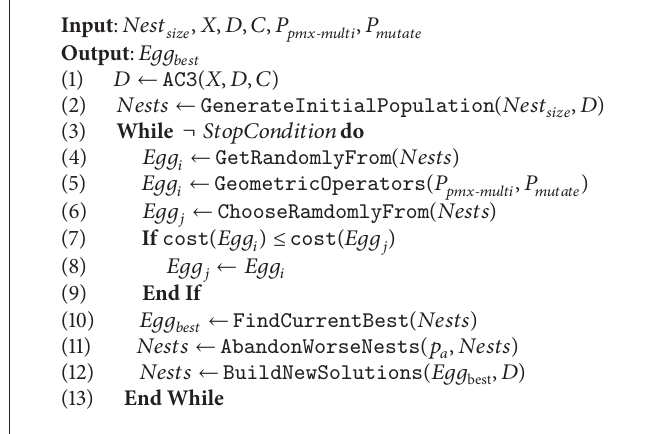
Algorithm 8: Prefiltered discrete cuckoo search.